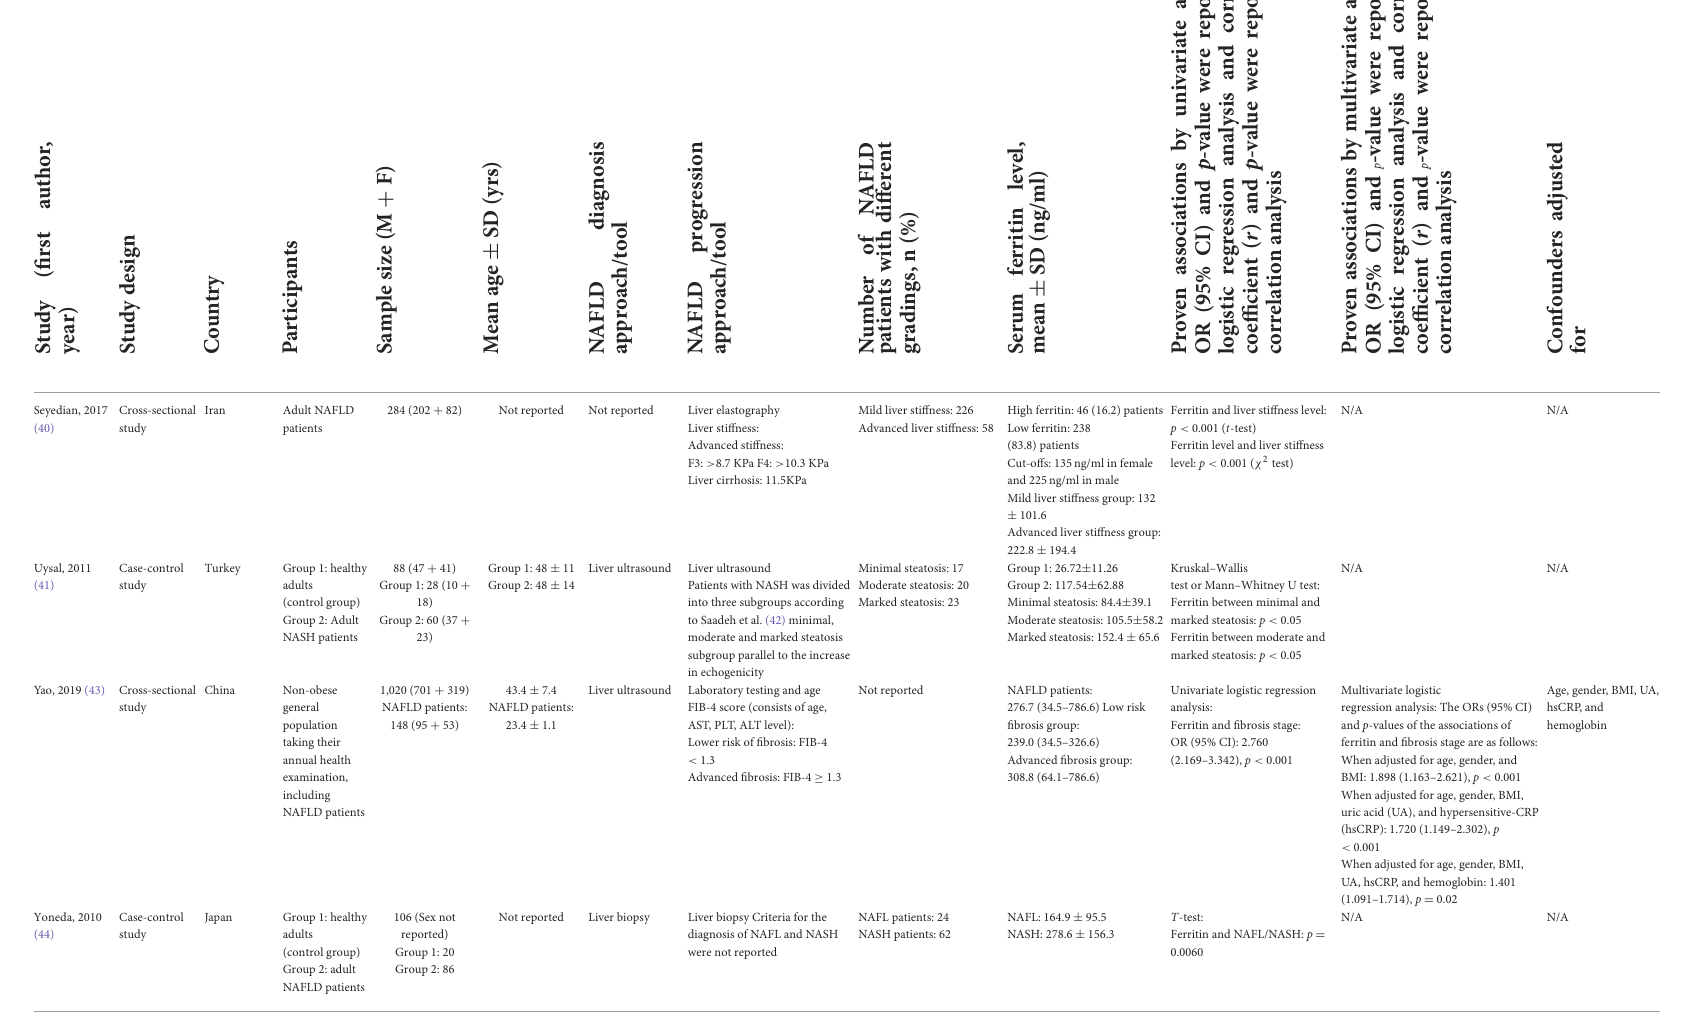
NAFL:164.9 ± 95.5 NASH:278.6 ± 156.3